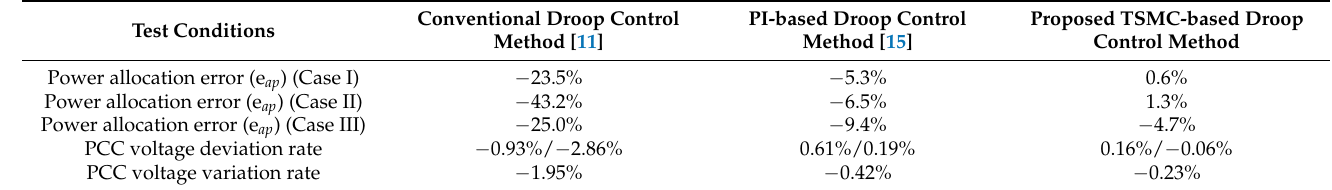
Table 4. Performance comparisons of different control